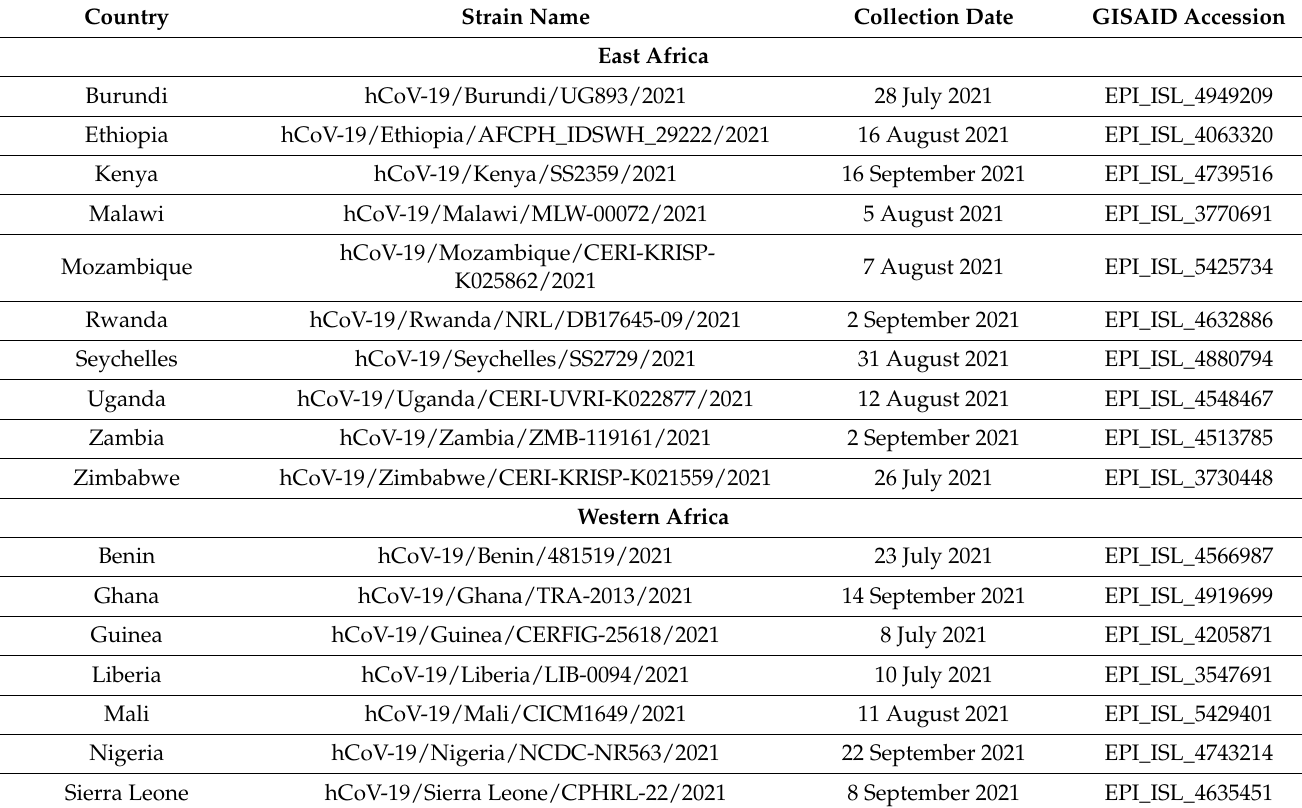
Table 7. Most recent reported occurrences in different countries on the African continent according